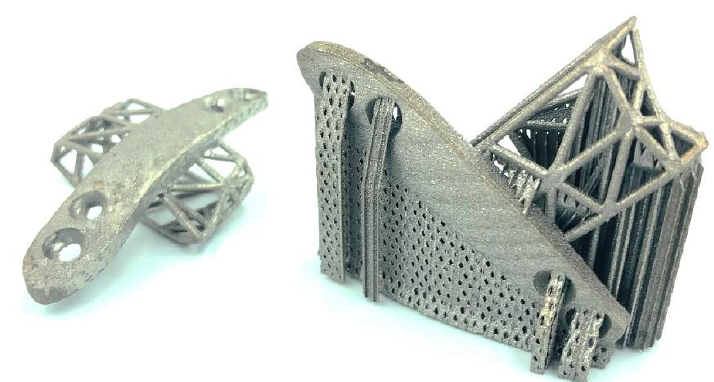
Figure 7. The additively manufactured titanium implant with the supports (right) and without the supports (left). Table 7. The mesh sensitivity analysis of the nominal CAD implant surface with respect to the optically scanned implant surface.